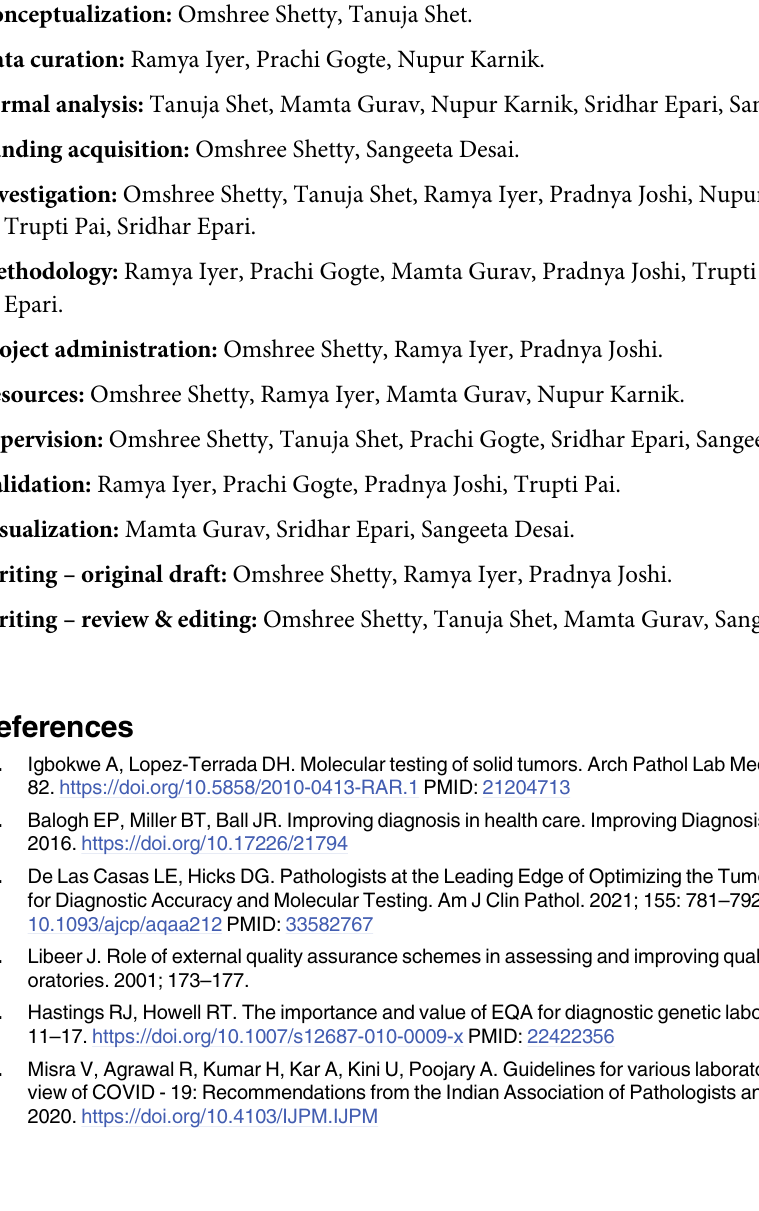
S1 Table. Calendar schedule of MPQAP EQAS for the year